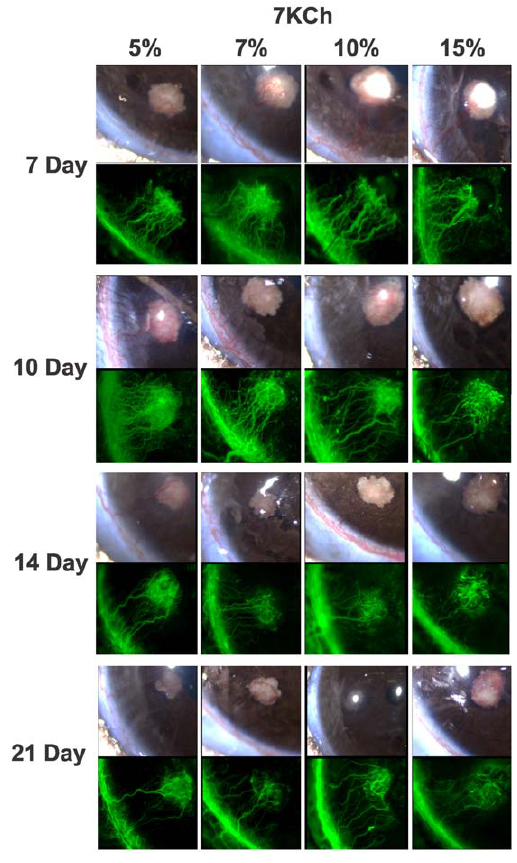
Figure 3. Effects of time and 7KCh concentrations on angiogenesis. Wafers containing 5, 7, 10 and 15% 7KCh (w/w) were implanted into rats anterior chambers as described in Fig. 1 and representative images are shown at 7, 10, 14 and 21 days. The vessel volume for each panel is shown in Fig. 4b, in mm 2 .